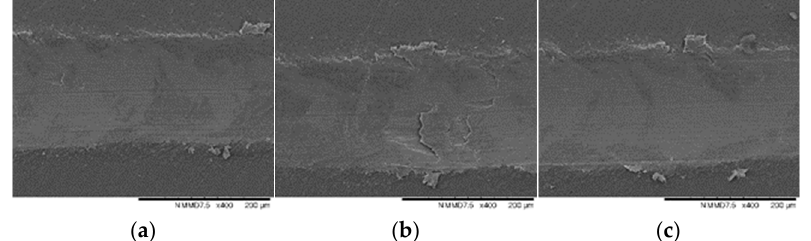
Figure 14. Image of the scratch tests carried out on: HA coating before the first sign of adhesive failure Lc 1 —( a ), HA coating at Lc 1 —( b ) and SiC-HA coating before Lc—( c ).